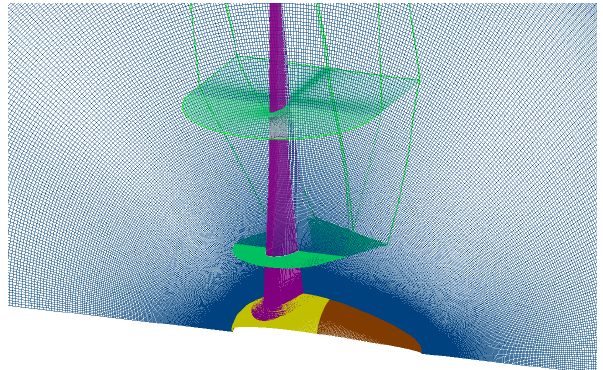
Figure 4. Integration of the blade mesh into the nacelle grid.